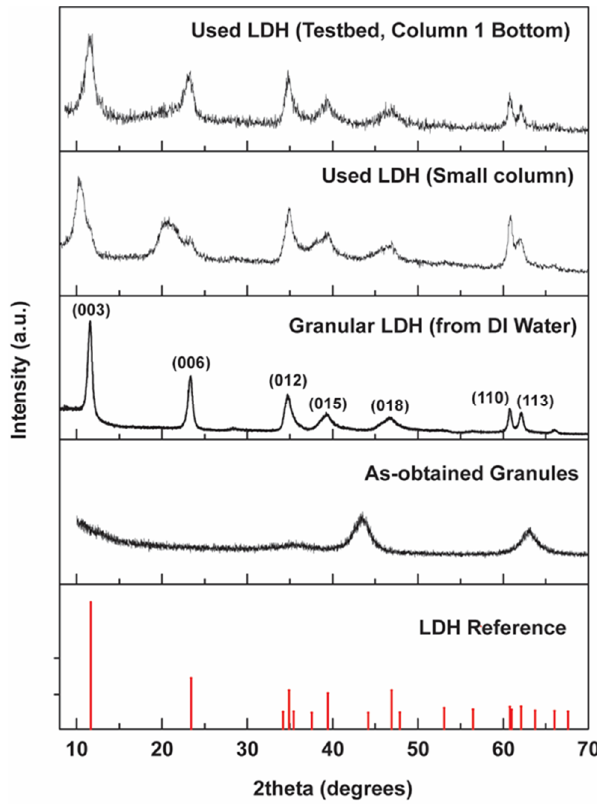
Figure 8. XRD patterns of as-obtained mixed metal oxide granules, granular LDH formed after immersion of as-obtained granules into DI water purged with N 2 , and exhausted media from small-scale (1.1 cm) and testbed (2” = 5.08 cm diameter, media taken from bottom of column 1) column tests used for treating CT blowdown. The pattern for (Mg 0.667 Al 0.333 )(OH) 2 (CO 3 ) 0.167 (H 2 O) 0.5 from PDF 01-089-0460 is shown as reference.